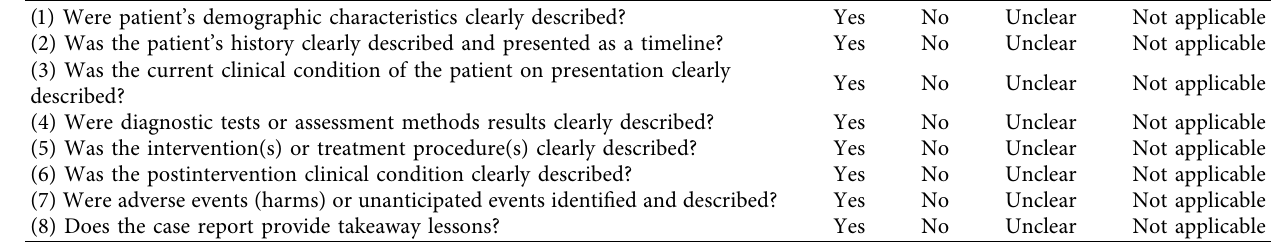
Table 1: Te Joanna Briggs Institute (JBI) critical appraisal checklist for case